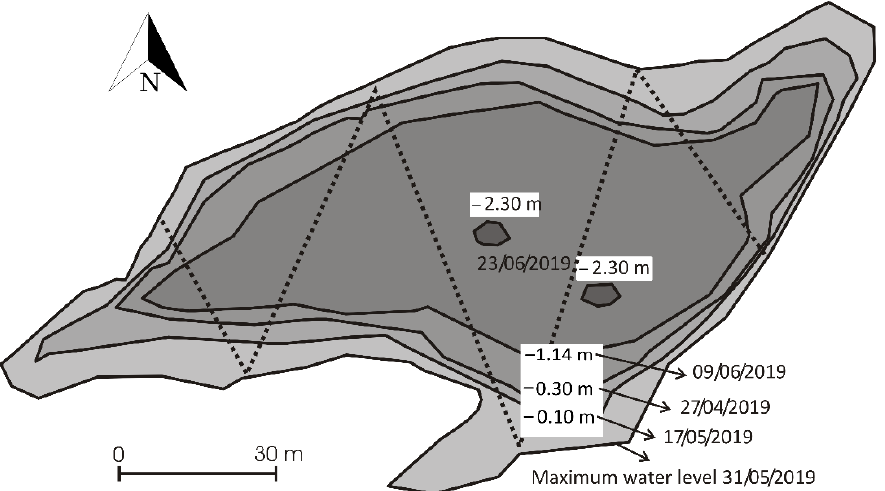
Figure 2. Pond planimetry and bathymetry. Numbers indicate meters below the maximum water level, for each sampling date in 2019. Dashed lines indicate the position of the transects.